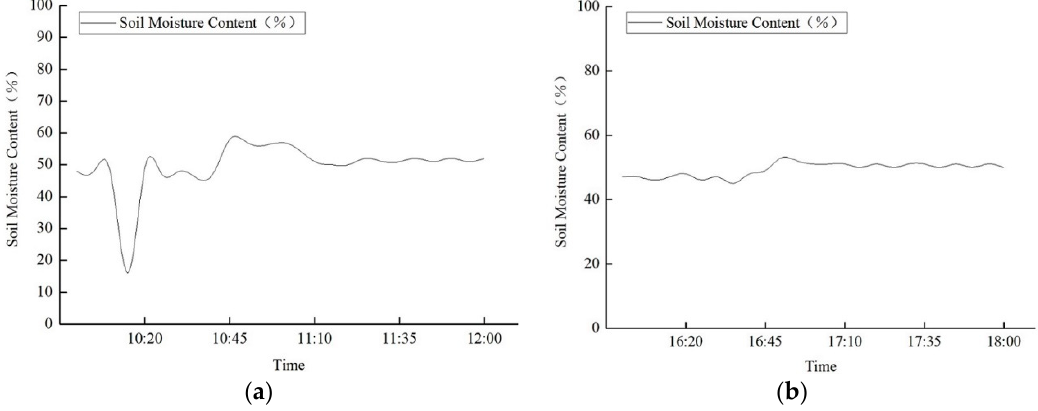
Figure 6. Comparison of data filtering curves. ( a ) Soil moisture before filtering and ( b ) soil moisture after filtering.